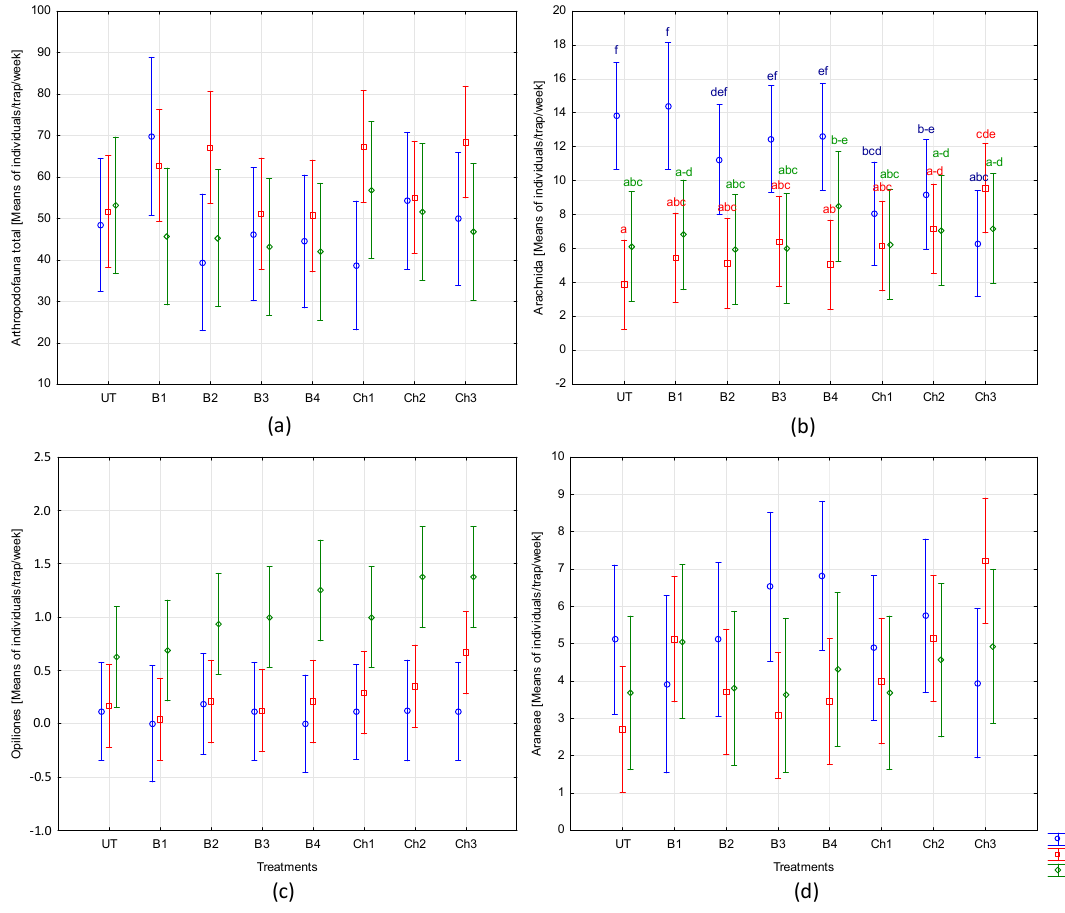
Figure 2. Number of trapped individuals of ( a ) arthropodofauna total, ( b ) Arachnida total, ( c ) Opiliones and ( d ) Araneae in broad bean crop depending on the protection method used: Treatments are the same as in Table 1. Vertical bars denote 0.95 confidence intervals. Means followed by the same letters are not significantly different according to the LSD test ( p < 0.05), factors: year x protection method. Table 3. Results of the statistical analysis of the presence of investigated arthropodofauna total and selected groups of invertebrates. SS —sum of squares, df —degrees of freedom, MS —mean squares, F —Fisher-Snedecor’s test, p —probability level. Effects SS df MS F